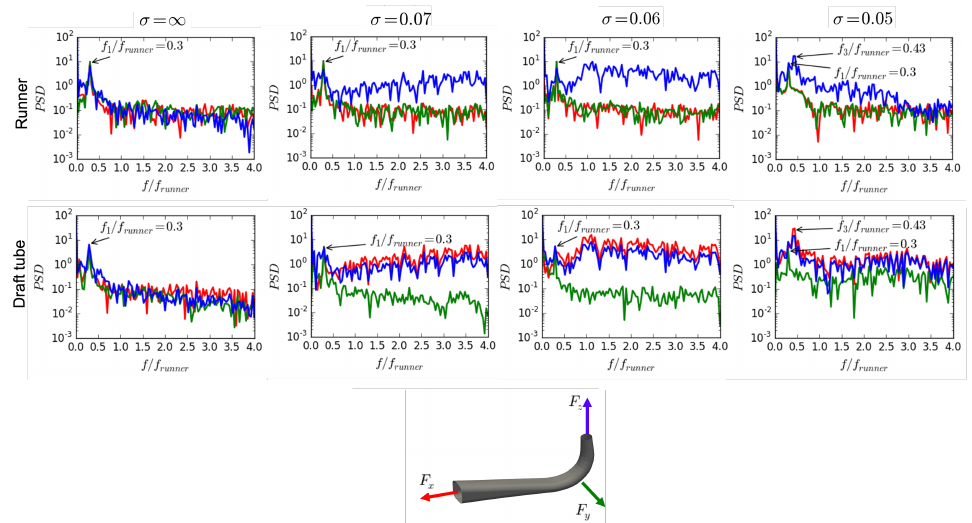
Figure 18. Effect of cavitation on the forces exerted on the runner and draft tube. Curve colors correspond to colors of coordinate